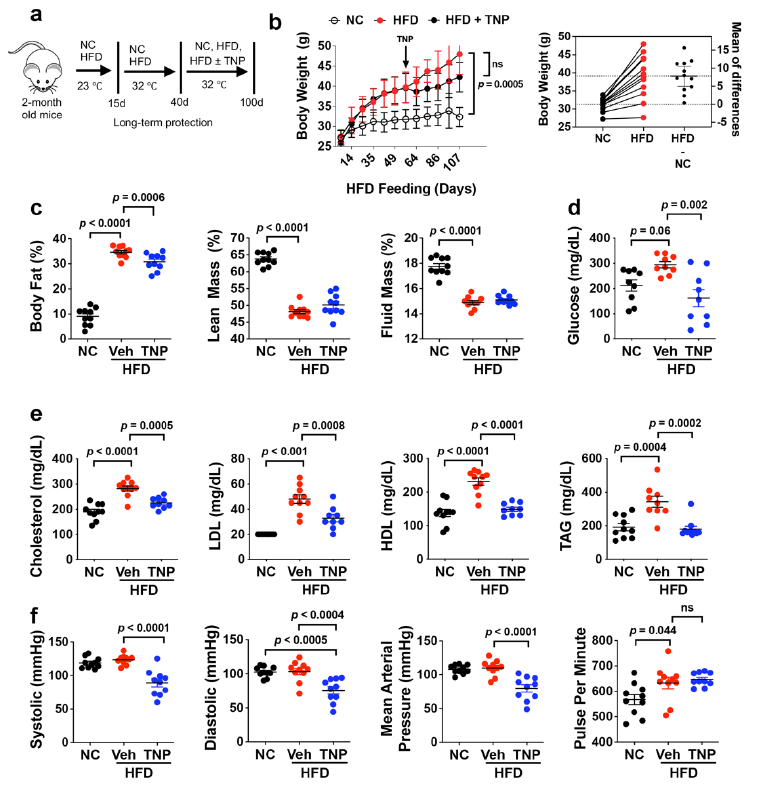
Figure 1. TNP protects mice from HFD-induced weight gain, hyperglycemia, and hyperlipidemia. ( a ) Schematic of the feeding regimen and timing of daily TNP administration (10 mg/kg BW, IP). NC, normal chow; HFD, high-fat diet. ( b ) Mouse body weights measured at weekly intervals over the feeding time course and estimation plot of vehicle and TNP-treated HFD mice showing raw data ( left ) and the group means difference with 95% confidence interval ( right ). ( c ) Baseline and endpoint measures of body fat, lean mass, and fluid mass in mice from ( a ). ( d , e ) Endpoint measure of blood glucose levels ( d ) and serum cholesterol, LDL, HDL, and TAG levels ( e ) in mice from ( a ). ( f ) Endpoint measures of systolic, diastolic, and mean arterial pressure and pulse rate of mice in ( a ). Data are mean ± SD (n = 8–14 mice/group). In Prism 9, p -values are by one-way ANOVA and Tukey’s post hoc test for ( b – f